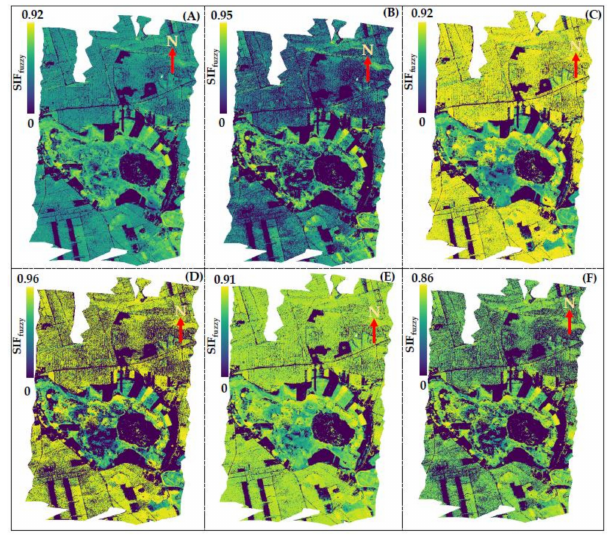
Figure 6. Simulated SIF fuzzy maps developed through the integration of membership maps and